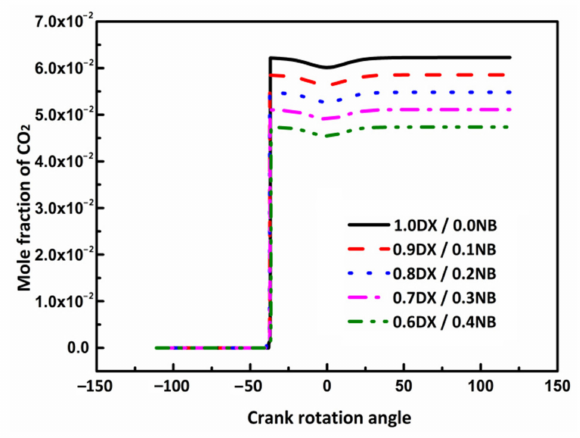
Figure 16. Effect of DX and n-butanol blending ratio on CO 2